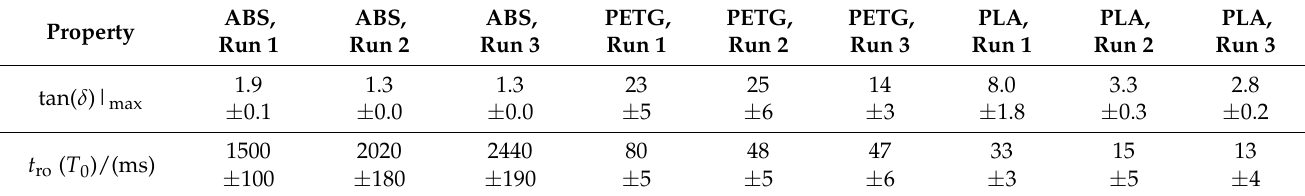
Table 3. Maximum of the loss factor, tan( δ )| max , and rouse relaxation time, t ro , at a reference temper- ature T 0 of 180 °C for three subsequent measurement runs.